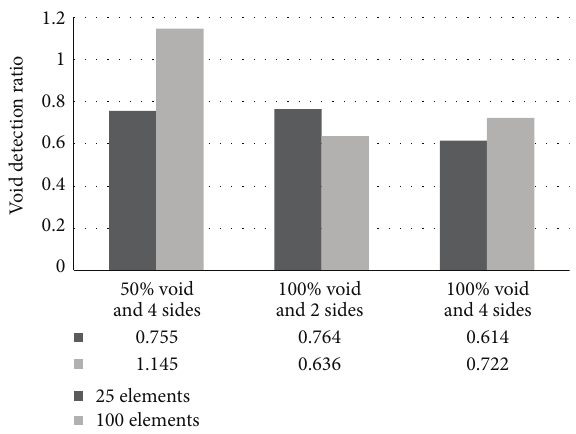
Figure 21: Ratio of detected void to actual void regarding the 25 elements and 100